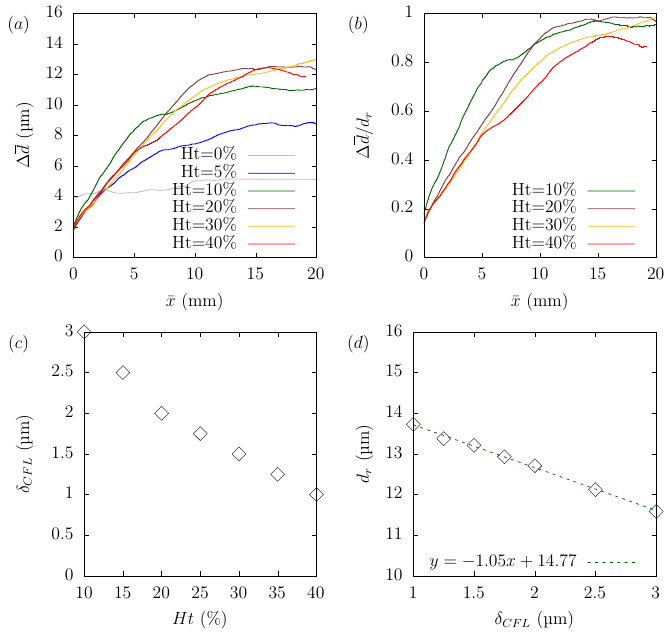
Figure 8. Hematocrit dependency of platelet margination. ( a ) Change of d as a function of distance traveled toward the streamwise direction x . ( b ) Rate of d normalized by the stable position d r for each case as a function of x . ( c ) Relationship between the hematocrit level and the width of the CFL δ CFL calculated from the distance where the local hematocrit in the equilibrium state is under 0.5%. ( d ) Relationship between the width of CFL δ CFL and the stable position of platelets d r